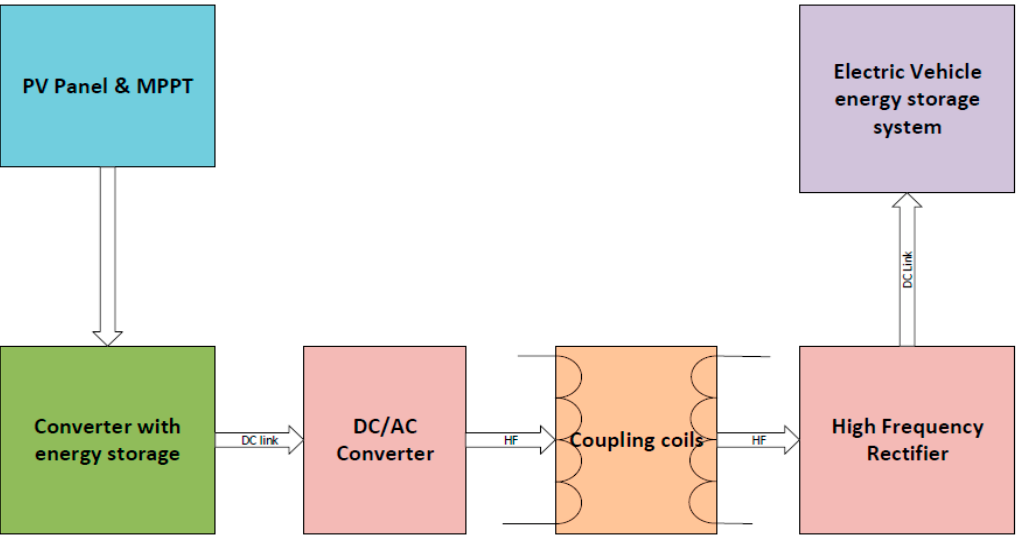
Figure 1. Overview of wireless charging powered by a solar panel.